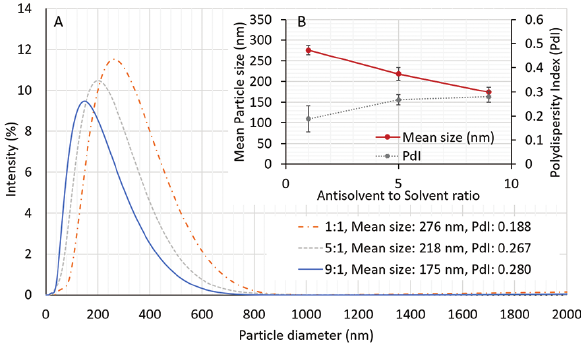
Figure 8: Effect of antisolvent to solvent ratio at 12 mL/s and 1200 rpm on the grooved disc, (a) PSD, (b) plot of mean particle size and PdI.